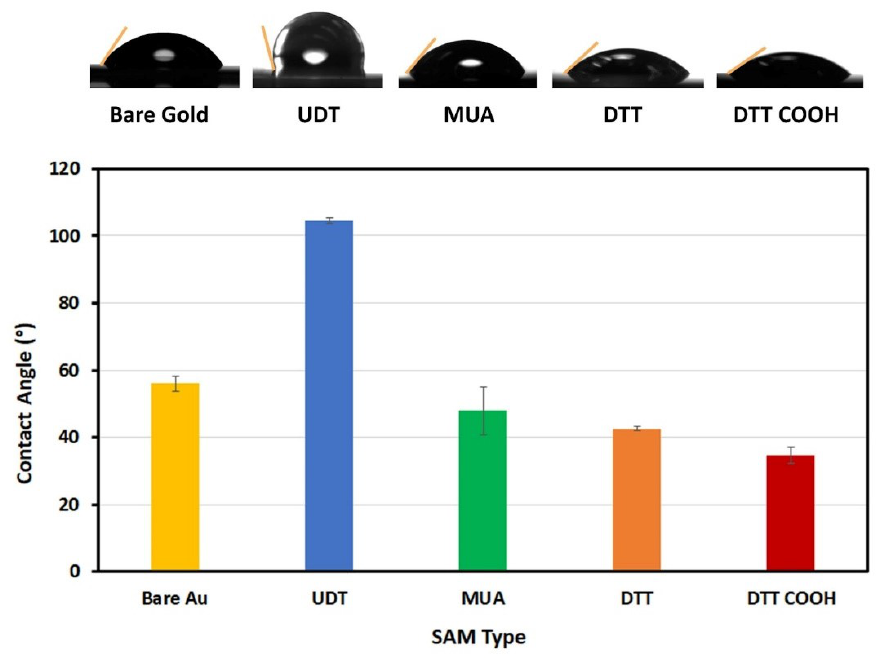
Figure 8. Contact angles of Milli-Q water droplets on gold electrodes with different SAM coatings. DTT- and DTT COOH -modified QCM crystals had angles of 43° ± 1° and 35° ± 5°, re- spectively. DTT’s contact angle ha s a similar trend to values in the literature [27,28]. These results confirmed surface modification, as DTT and DTT COOH SAMs were more hydro- philic compared to bare gold. While CAG is useful for confirming functionalization, it d oes not indicate the SAM’s density. We expect a disordered DTT COOH layer as DTT binding to gold has been con- firmed to be in a disordered way. As a less dense SAM is more likely to have vacancy islands due to gold surface atoms rearranging during thiol functionalization [27], in this work, we used β -mercaptoethanol to passivate any exposed gold which could be easily subject to NSA. To estimate the density of DTT COOH ’s SAM, incubating QCM discs in -flow with DTT COOH followed by a linear thiol molecule is an object of further investigation. 3.2. Electrochemical Characterization of the Aptasensor Electrochemical experiments were performed to further investigate the surface prop- erties of the aptasensor. We applied cyclic voltammetry (CV) and square wave voltamme- try (SWV) to characterize each step of surface modification of the gold electrodes using 5 mM K 4 [Fe(CN) 6 ]/K 3 [Fe(CN) 6 ] as an external redox probe. Figure 9 shows the conventional SWV experiments followed by the reverse scan to monitor both oxidation and reduction reactions; this approach provides data that are equivalent to cyclic square wave voltam- metry (CSWV) [20]. The decline in SWV current intensity after DTT COOH modification is due to producing a self-assembled monolayer of DTT COOH on the gold electrodes, which also results in increasing the peak-to-peak separation of the redox signals in the CV (see Figure S6 of Supplementary Material). Although the current intensity was expected to decrease significantly after the final modification step, the current intensity increased (Fig- ures 9 and S6), indicating that the aptamer may be involved in electron transfer.